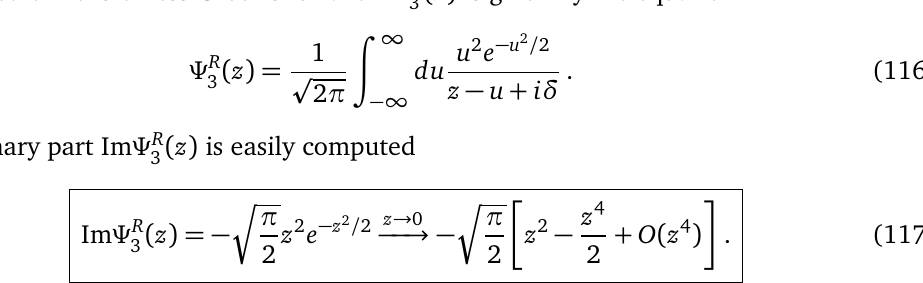
( z )] (red curve), Im [ Ψ R 3 ( z )] (blue 3